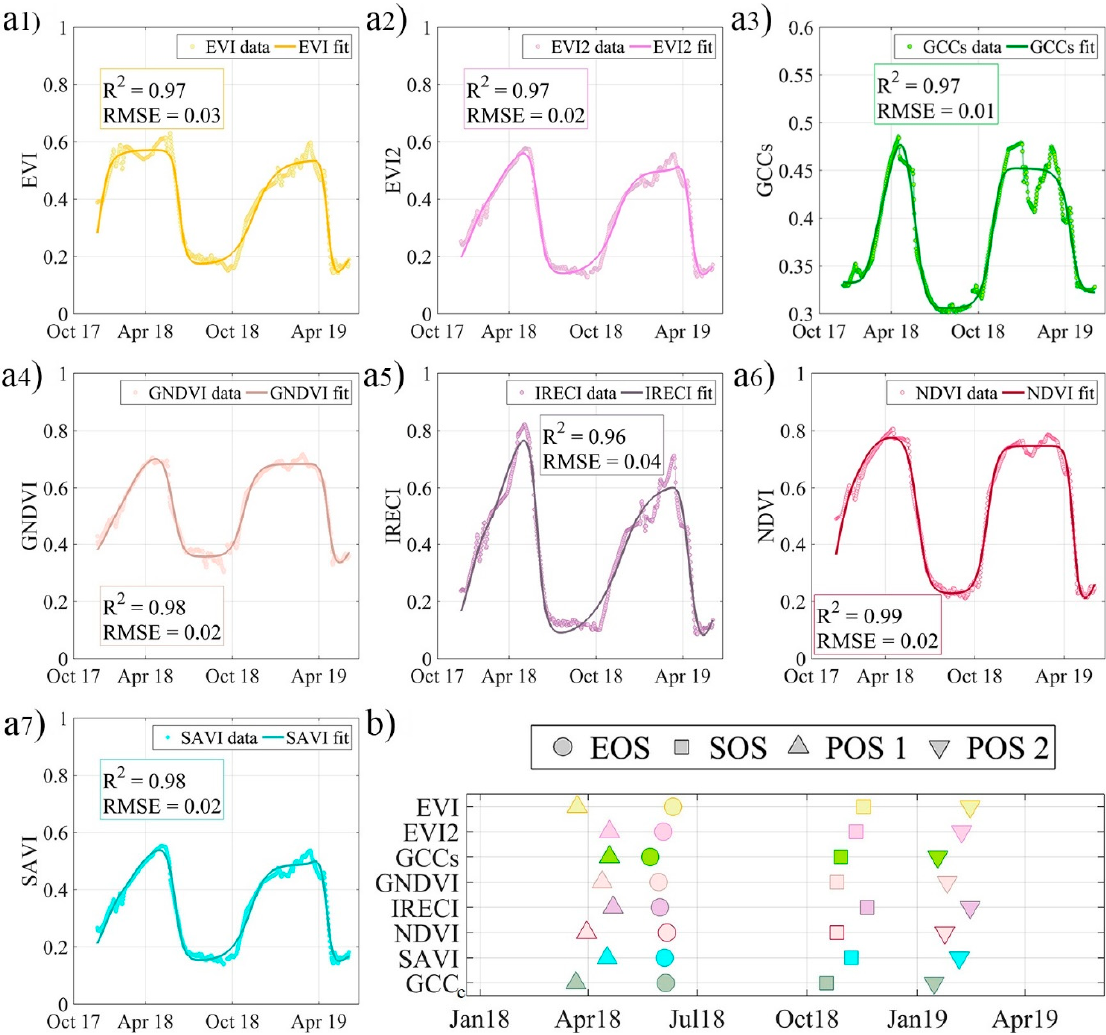
Figure 6. ( a ) Evolution of vegetation indices (raw data, fitted function and error) throughout the study period (a1 = EVI, a2 = EVI2, a3 = GCCs, a4 = GNDVI, a5 = IRECI, a6 = NDVI, a7 = SAVI). ( b ) Comparison of the phenological dates of GCCc and satellite VIs in period A.